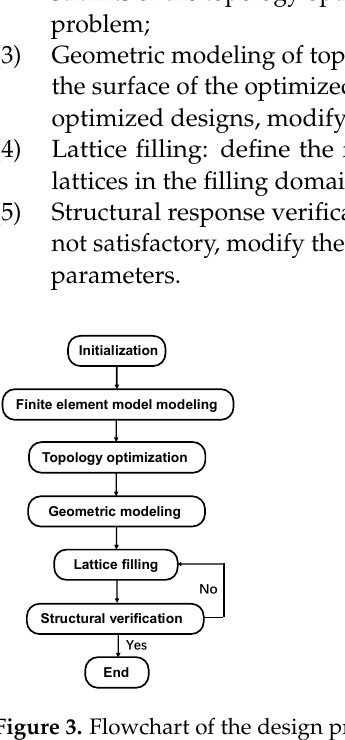
Figure 3. Flowchart of the design process of the lattice-filled